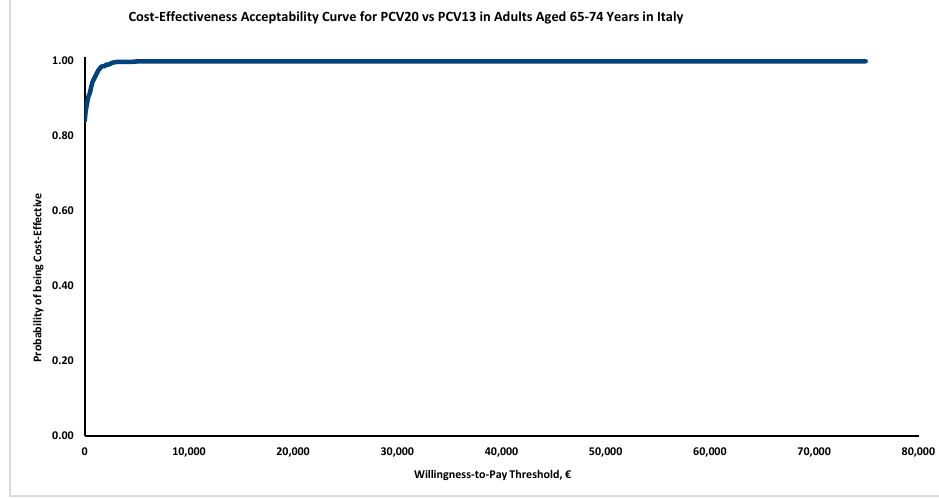
Figure 2. Cost-effectiveness acceptability curve. Willingness-to-Pay Threshold, € Cost-Effectiveness Acceptability Curve for PCV20 vs PCV15 in Adults Aged 65-74 Years in Italy